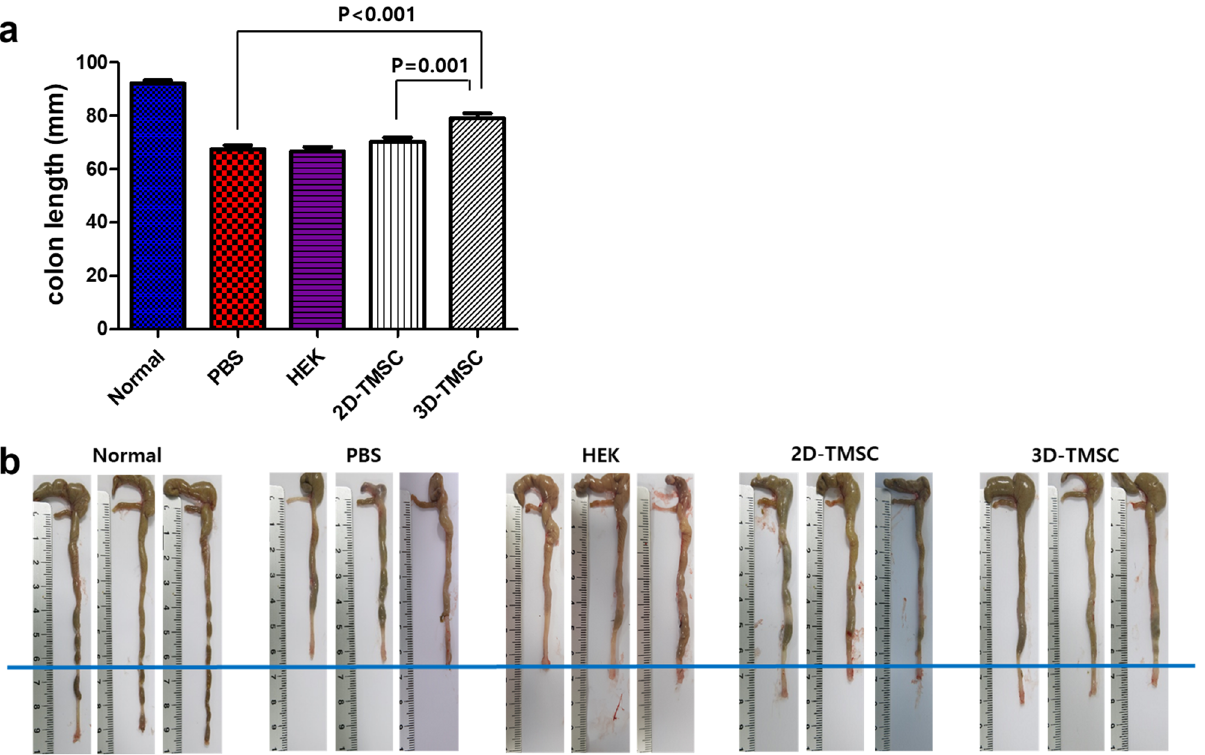
Figure 5. Colon length recovery after treatment with 3D-cultured TMSCs. ( a ) The colon length shortening in the 3D-TMSC-treated group was significantly lower than that in the DSS + PBS control (P < 0.001), DSS + HEK control (P = 0.001) and 2D-TMSC-treated groups (P = 0.001). ( b ) The lengths of the colon in each group are indicated. 3D, three-dimensional; 2D, two-dimensional; TMSCs, tonsil-derived mesenchymal stem cells; DSS, dextran sulfate sodium; PBS, phosphate-buffered